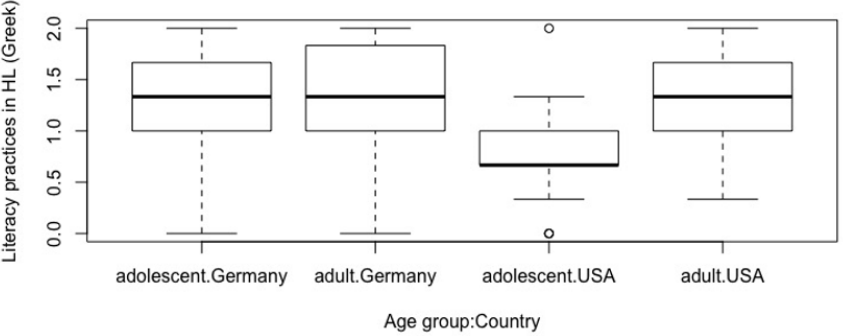
Figure 8. Literacy practices in the HL (Greek) for each heritage group (USA, Germany) and age group (adults, adolescents).